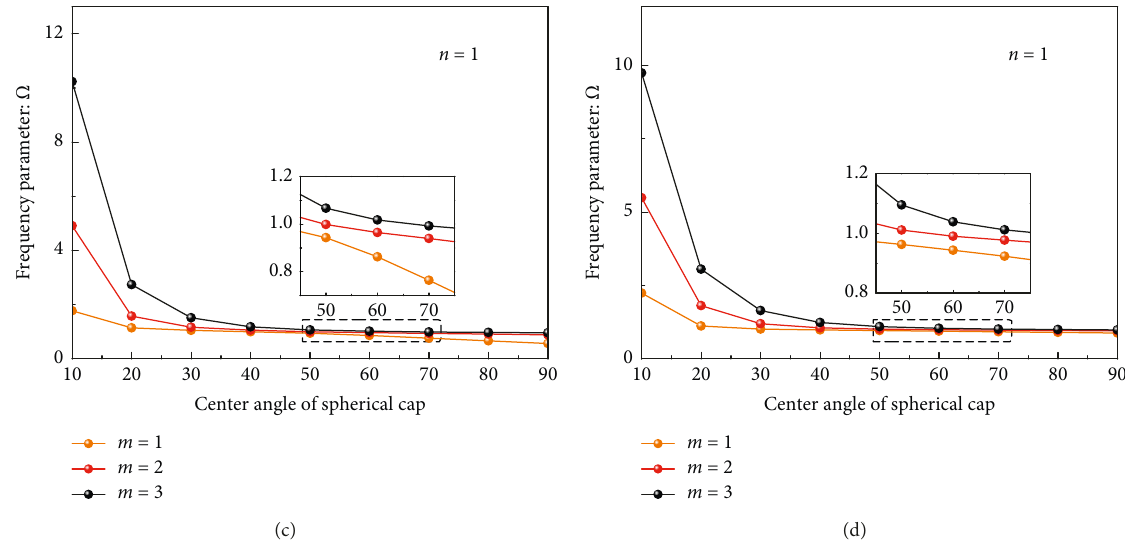
Figure 8: Frequency parameters Ω of uniform spherical cap with different center angles and boundary conditions. (a) Axial elastic support boundary condition. (b) Clamped boundary condition. (c) Shear support boundary condition. (d) Free boundary condition.